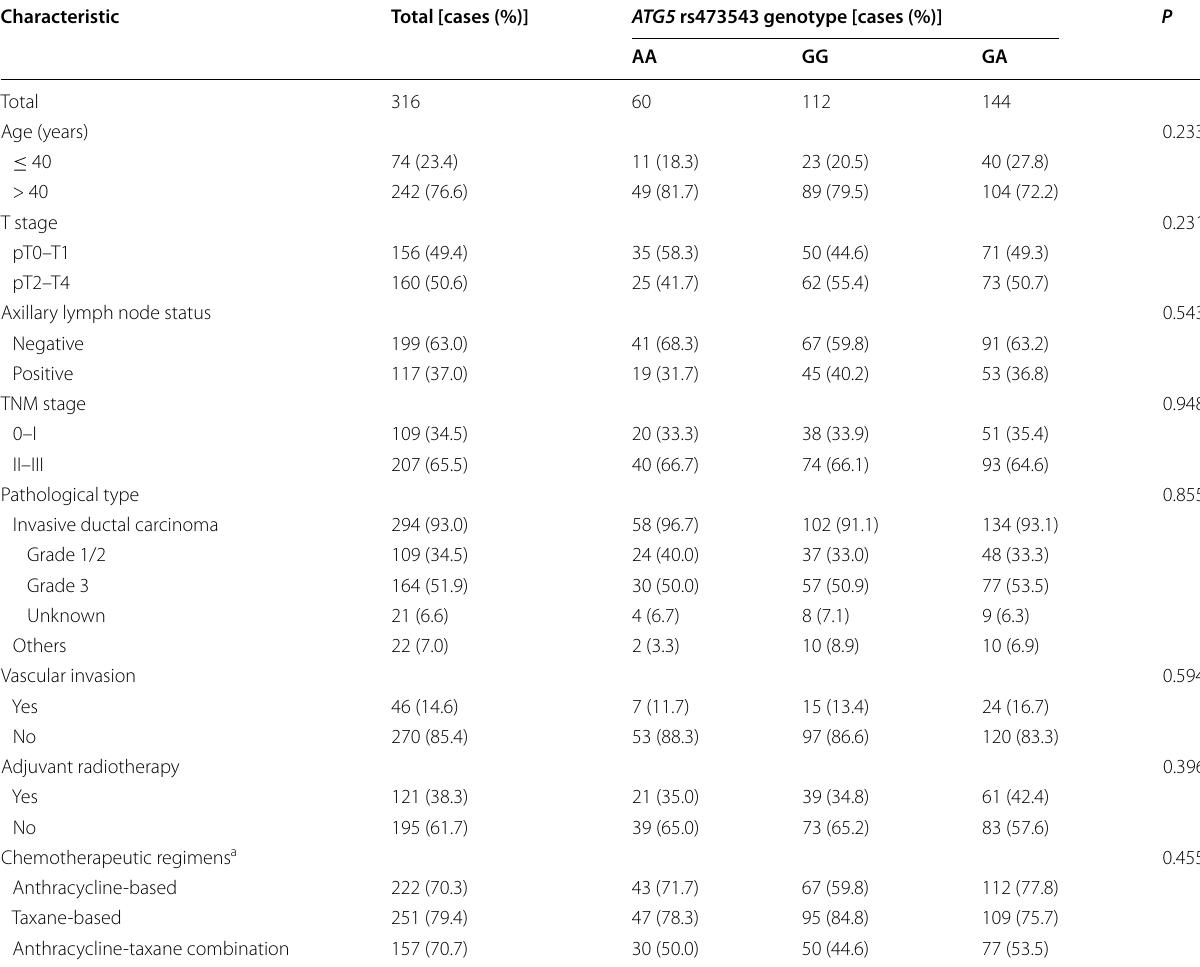
Table 1 Clinicopathological characteristics of patients with triple-negative breast cancer (TNBC) with respect to autophagy-related gene 5 ( ATG5 ) rs473543